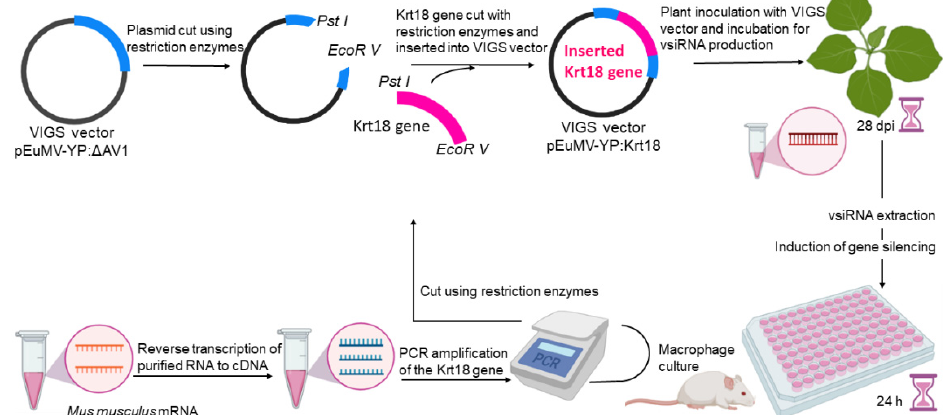
Figure 1. Scheme of the construction of pEuMV-YP:Krt18 vector and production of virus-derived small interfering RNAs (vsiRNAs) in plants with cross-kingdom gene silencing potential (created in biorender.com).